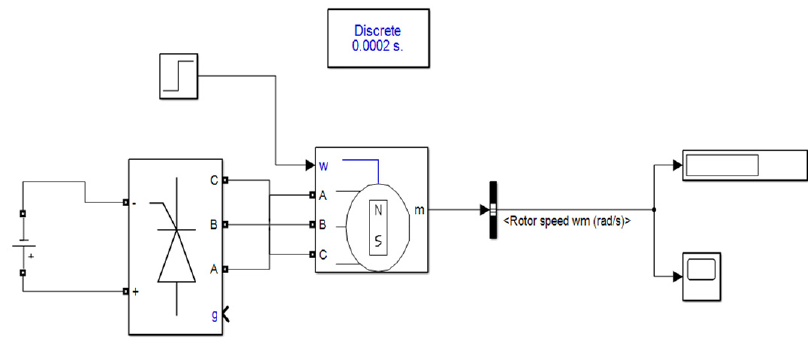
Figure 5. Motor driver model.